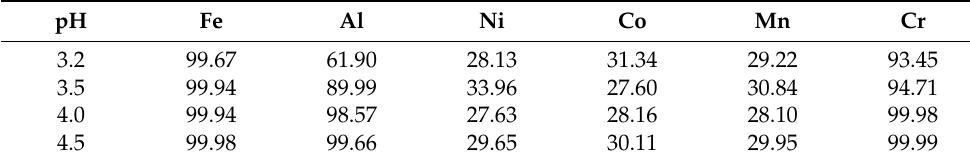
Table 2. Removal of Fe, Al and Cr from the leach solution (%). pH Fe